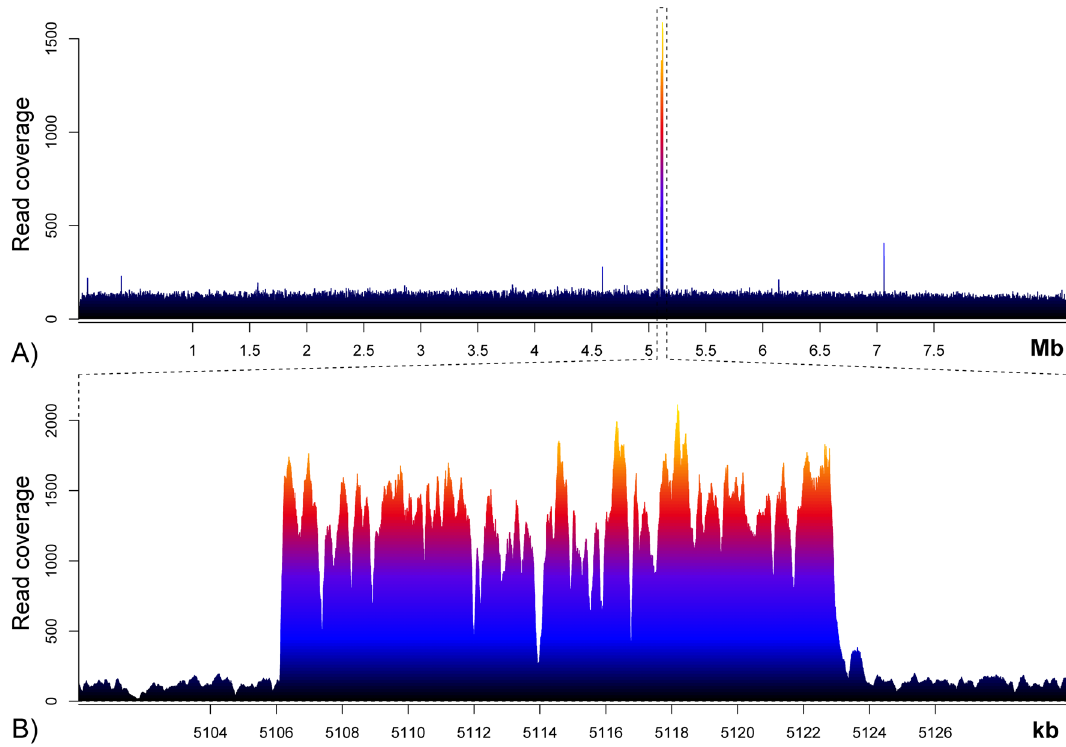
Figure 3. Mapping of sequencing reads on the reference chromosome sequence of S. coelicolor A3(2). ( A ) Sequence coverage of S. coelicolor A3(2) chromosome. ( B ) Zoom of the region comprised between positions 5,100,000 and 5,130,000 of the reference genome